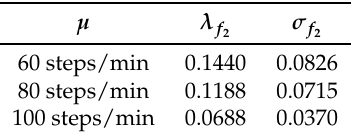
Table 3. Training of the algorithm, f 2